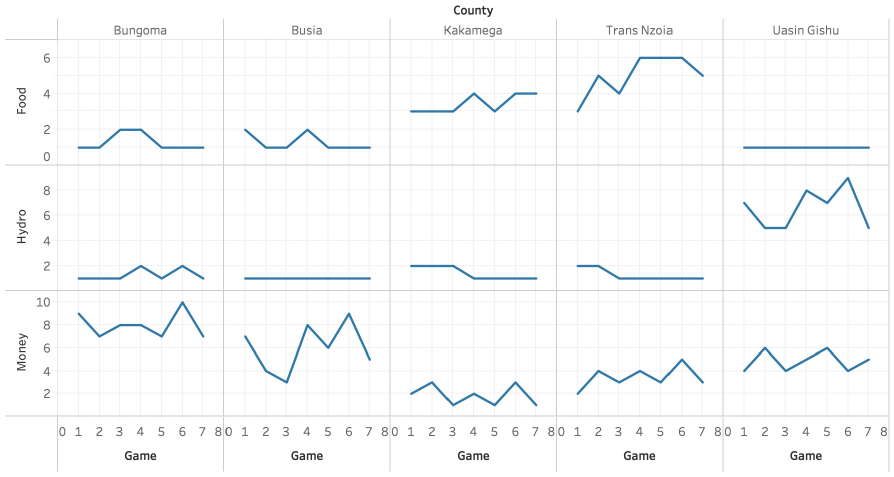
Figure 3. The changes in the resources (Food, Energy in the form of Hydroelectric Power and Money) in the seven game sessions for the five county governments.